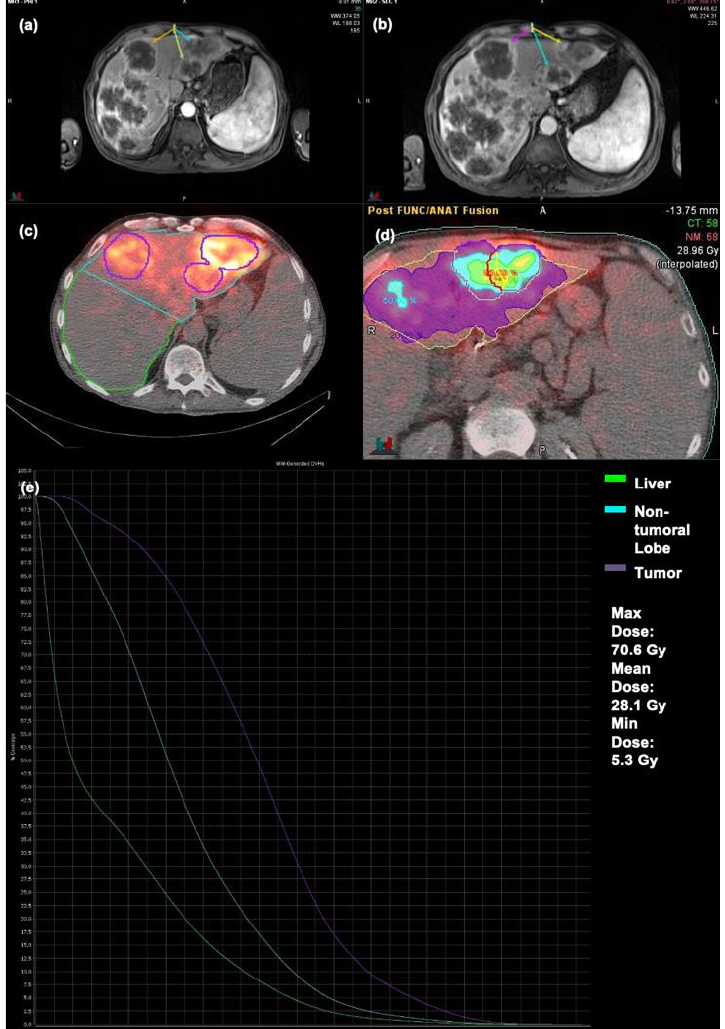
Figure 5. Patient failing to show OR following Y90 therapy ( a ) Pre-op MRI ( b ) Post-op MRI ( c ) Bremsstrahlung SPECT/CT ( d ) Dosimetry map ( e ) DVH Curve. Table 3. Overall Characteristics and Median Overall Survival from Hepatic